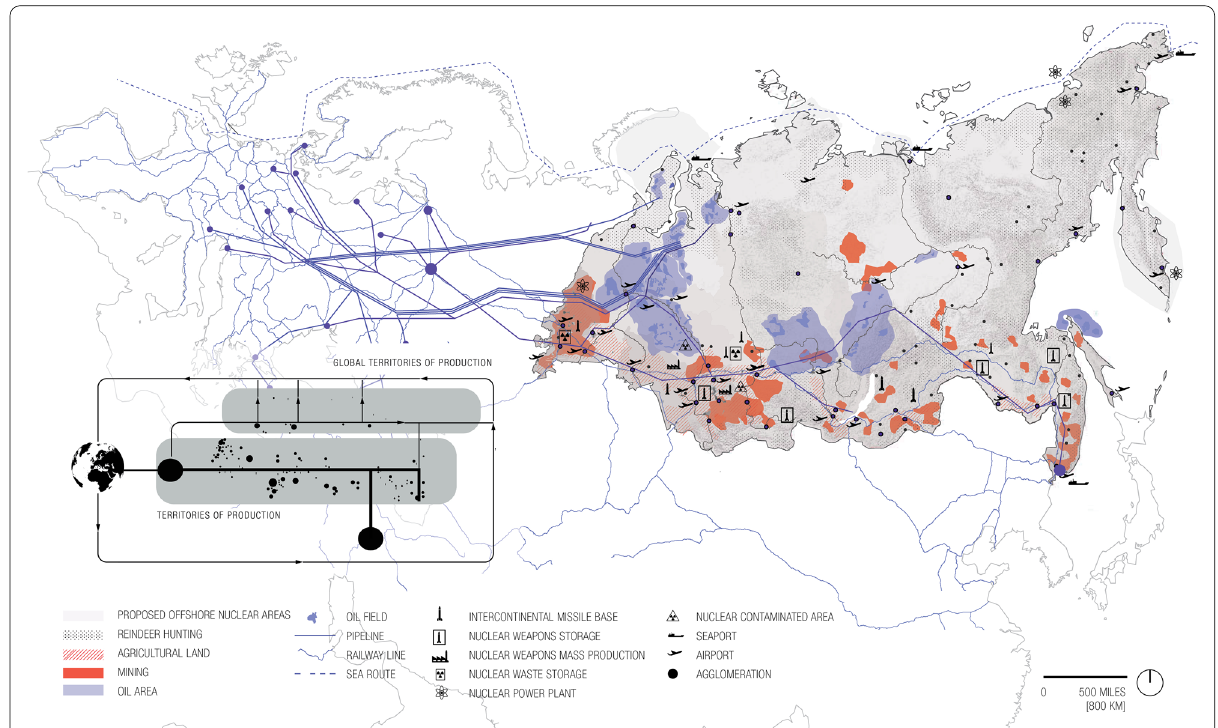
Fig. 3 Siberia: Third Spatial Regime. Oil and gas resource extraction industries colonize the former remote areas of the North and West of the region. The areas of exception become integrated within economic circuits of production. Image credits: Salgueiro Barrio and O’Shea. Image Sources: Drawing 3:Cities: ESRI, Naumov, Wikipedia, Google Maps. Demographics: Russian Census and Wikipedia. Transportation networks: ESRI. Agriculture: http:// sedac. ciesin. colum bia. edu. Oil Fields:Russian Government Decree number 1715-3 “Energy Strategy of Russia for the period up to 2030,”ROSFNET: https:// www. rosfn et. comLUKoil: https:// www. lukoil. comPipelines: TRANSFNET https:// en. trans fnet. ruMilitary Industry: Globalsecurity.orgNuclear Uses: International Agency for Atomic